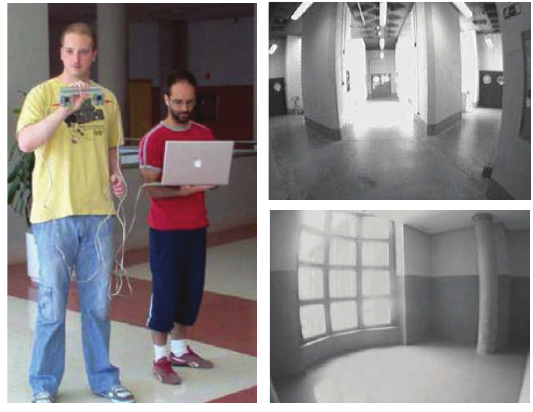
Figure 1. Stereo vision system for our 6DoF visual